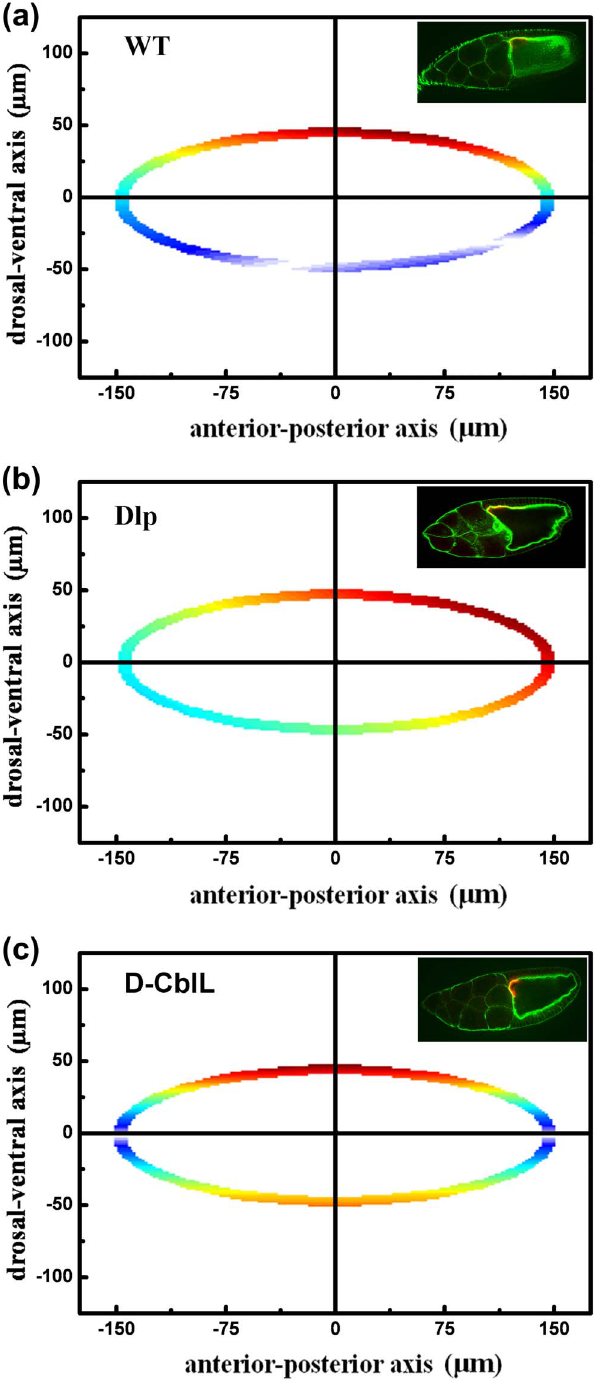
Figure 4. The spatial distribution of the morphogen Gurken gradient in (a) the stage 10A wild-type egg, (b) overexpressing Dlp egg, and (c) overexpressing D-CblL egg chambers which are possessed of (a) X 23 type, (b) X 1 type, and (c) Z 1 type symmetric operators, respectively. The insets show the schematic global distribution of the Gurken gradient in the stage 10A wild-type eggs, overexpressing Dlp eggs, and overexpressing D-CblL eggs, respectively.